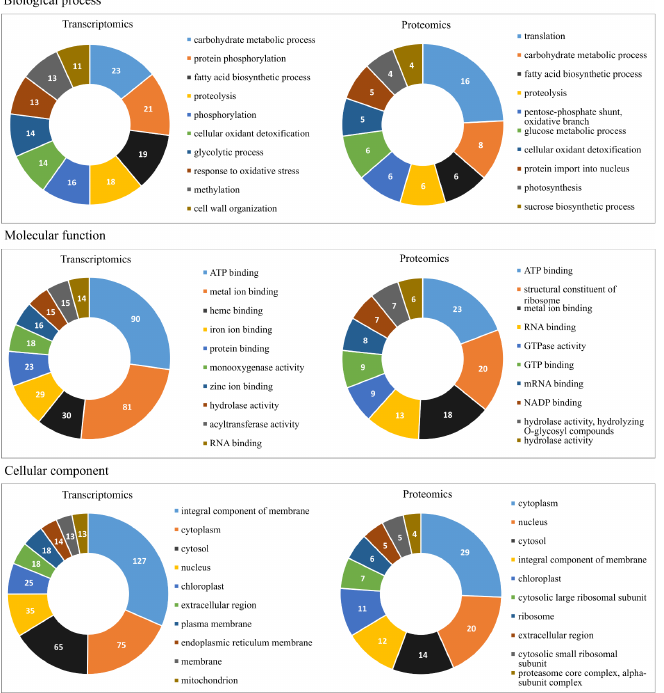
Figure 1. Gene Ontology (GO) annotation classification statistics graph from full-length transcriptome and proteome in the leaves of young oil palm plants under salinity stress; classified accordingly to biological process, cellular component, and molecular function. Only the ten most populated groups per GO term are shown. Numbers represent the amount of positive hits.